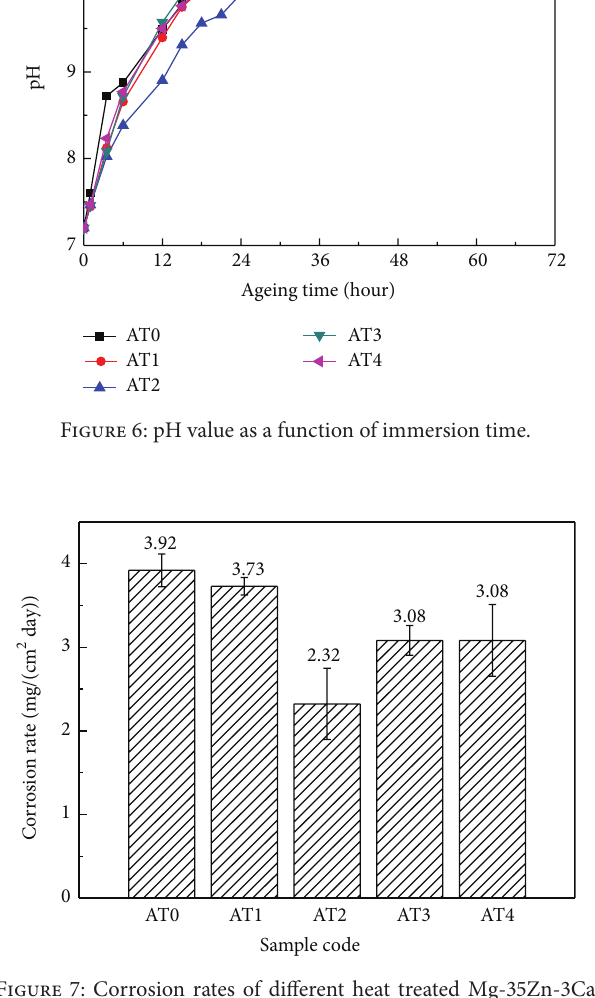
Figure 7: Corrosion rates of different heat treated Mg-35Zn-3Ca alloys after immersion in HBSS for 5 days.